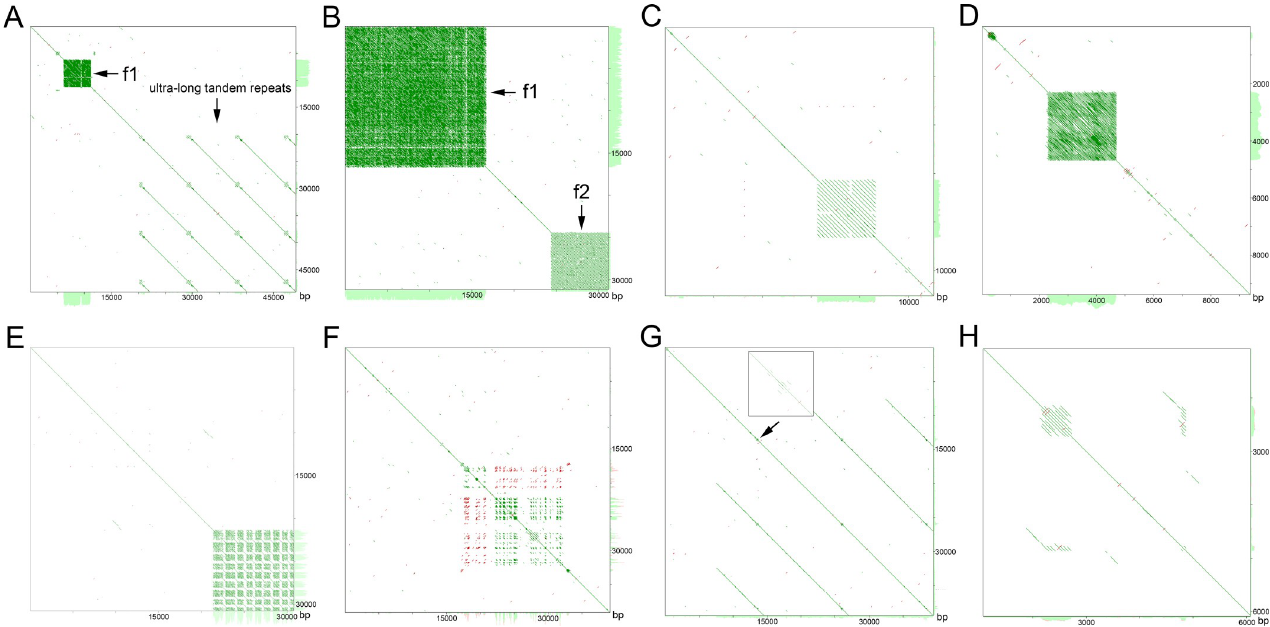
Fig 3. Self-to-self comparison of the ON reads displayed as dot plots (YASS program output), where parallel lines indicate tandem repeats (the distance between the diagonals is equal to the lengths of the motifs). (A) Array of the f1 satDNA family and long tandem repeats determined from read 17 of the ON reads for the C . acuminatum genome. (B) Colocalization of f1 and f2 satDNA family arrays in read 422 from the ON sequencing of the C . acuminatum genome. (C) Array of the f3 satDNA family in read 169 from the ON sequencing of the C . suecicum genome. (D) Array of the f4 satDNA family in read 210 from the ON sequencing of the C . suecicum genome. (E) Array of the f5 satDNA family in read 137 from the ON sequencing of the C . suecicum genome. (F) Array of the f6 satDNA family in read 2727 from the ON sequencing of the C . pamiricum genome. (G) Array of the f7 satDNA family in read 2621 from the ON sequencing of the C . pamiricum genome. (H) Array of the f8 satDNA family in read 5857 from the ON sequencing of the C . pamiricum genome.